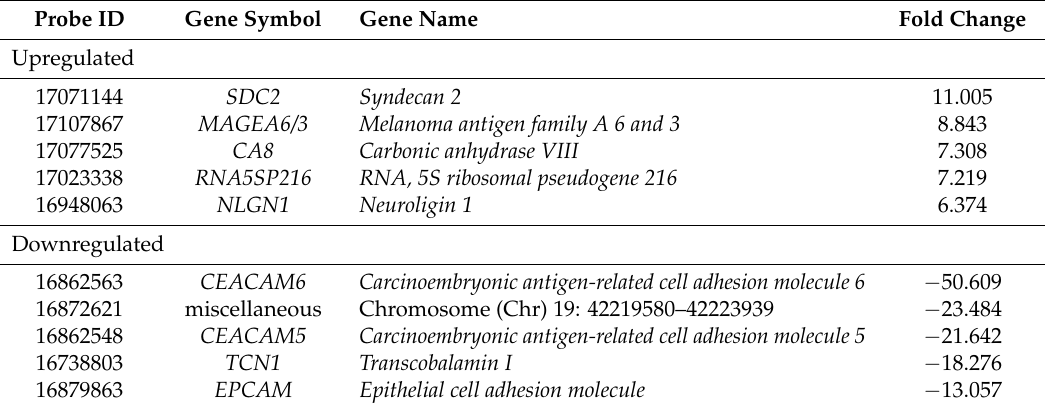
Table 1. Up- and downregulated genes in A549/D3 cells compared to A549 cells.